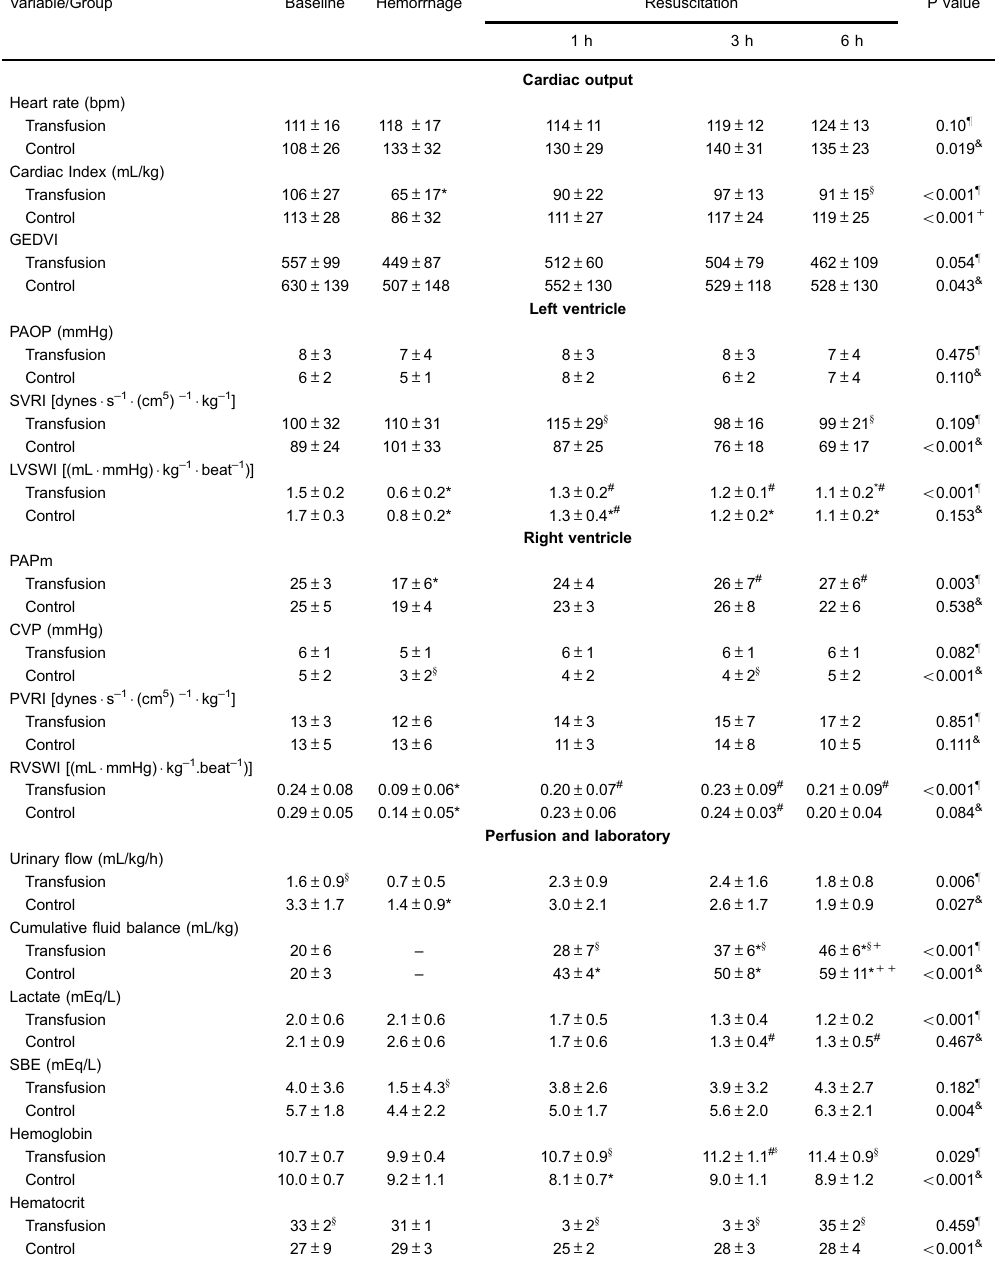
Table 1. Hemodynamic and laboratory variables of the groups during the study